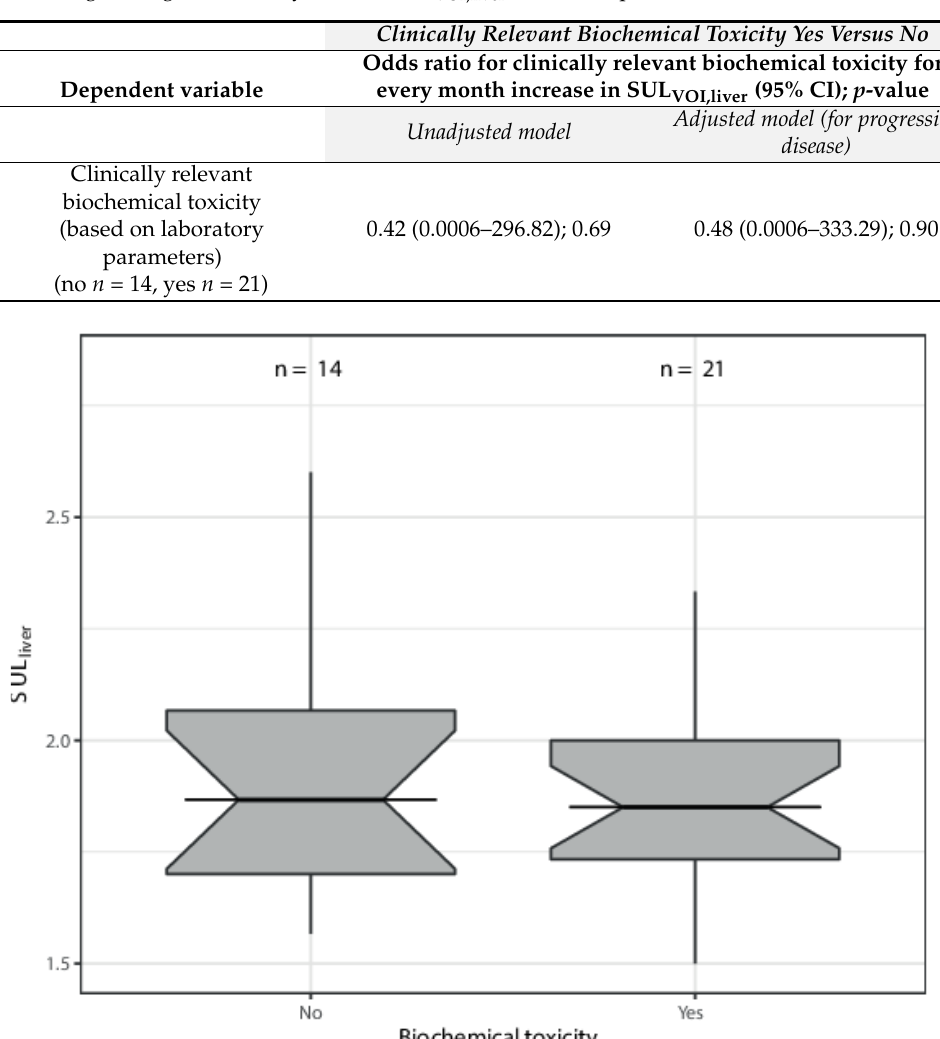
Table 5. Relation between SUL VOI,liver and clinically relevant biochemical toxicity based on mixed- effects logistic regression analyses with SUL VOI,liver as the independent variable.